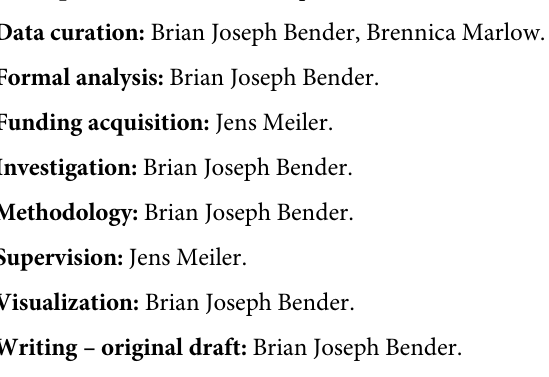
S2 Fig. Percent Identify of Best Available Template for Every Non-Odorant Human GPCR. For each receptor in the human genome, the best template was identified in the PDB. The sequence identity of the best available is plotted. Most templates cross the 20% threshold identified as critical for accurate modeling. The previous threshold of 40% identity is highlighted in red, and the new 20% identity threshold is highlighted in black. S3 Fig. Effect of Incorporation of a Ligand on Model Accuracy. One hundred models of the D3 receptor was modeled either with multiple low identity templates (red) or with a single high identity template (green) and the full model RMSDs are plotted as violin plots. As expected, the high identity template yields higher accuracy models on average. Incorporation of a ligand during the modeling process further improve the accuracy compared to the apo state for both multiple low identity templates (cyan) and a single high identity template (pur- ple). S1 Protocol. Protocol Capture for Homology Modeling from Low Identity Templates. Step-by-step guide to build models using this pipeline. Input data and scripts available at www.